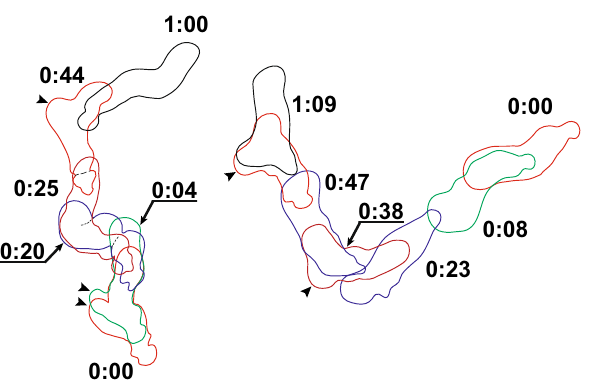
Figure 2. Kinograms of the locomotion of two cells on the glass substrate based on a video record. Time stamps are in minutes:seconds. Arrowheads indicate anterior bulges of the hyaloplasm. Scale bar = 10 µm.